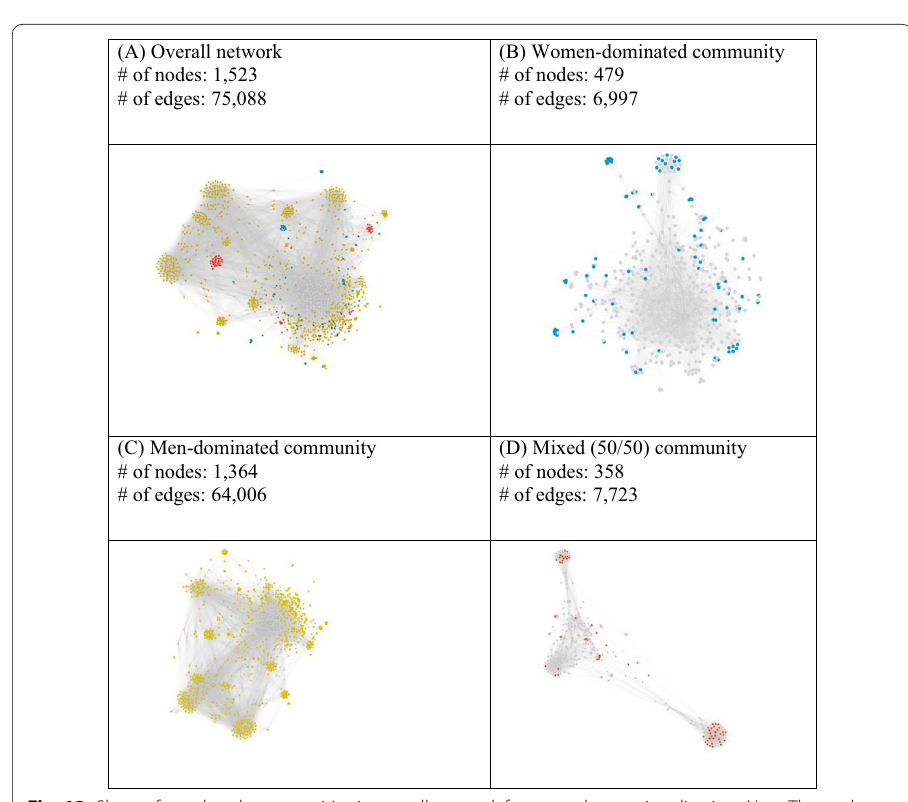
Fig. 12 Share of gendered communities in overall network for second operationalization. Note : The nodes are festivals that are connected, if they screen the same film. Overall, 1523 festivals are connected through the screening of 1323 films. This induces 75,088 (weighted) edges between festivals. In the grey overall network ( A ), festivals can be connected by sharing one or more films made by women-dominated core creative teams, by sharing one or more films made by men-dominated core creative teams, and by sharing one or more films made by mixed (50/50) core creative teams. The colored nodes show festivals that are exclusively connected through sharing one or more films made by women-dominated core creative teams ( B ), made by made by men-dominated core creative teams ( C ), and made by mixed (50/50) core creative teams ( D ). If a festival is colored, it only appears in one of the gendered community graphs. Layout based on Force Atlas Algorithm in Gephi